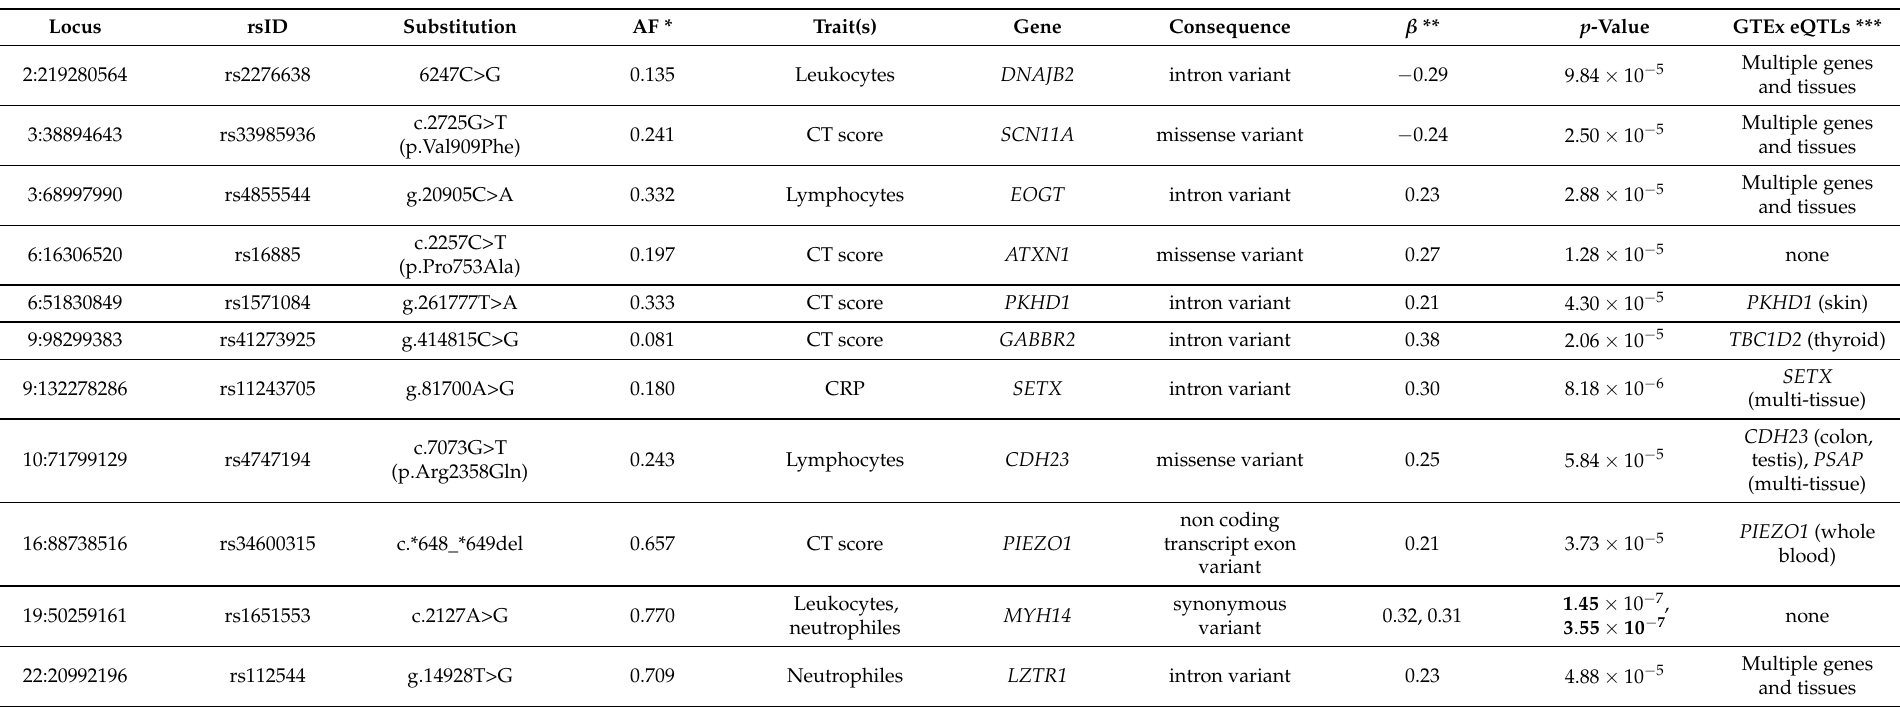
Table 1. Candidate genetic variants associated with COVID-19 related quantitative traits in a cohort of Russian patients. Locus rsID Substitution AF * Trait(s) Gene Consequence β ** p